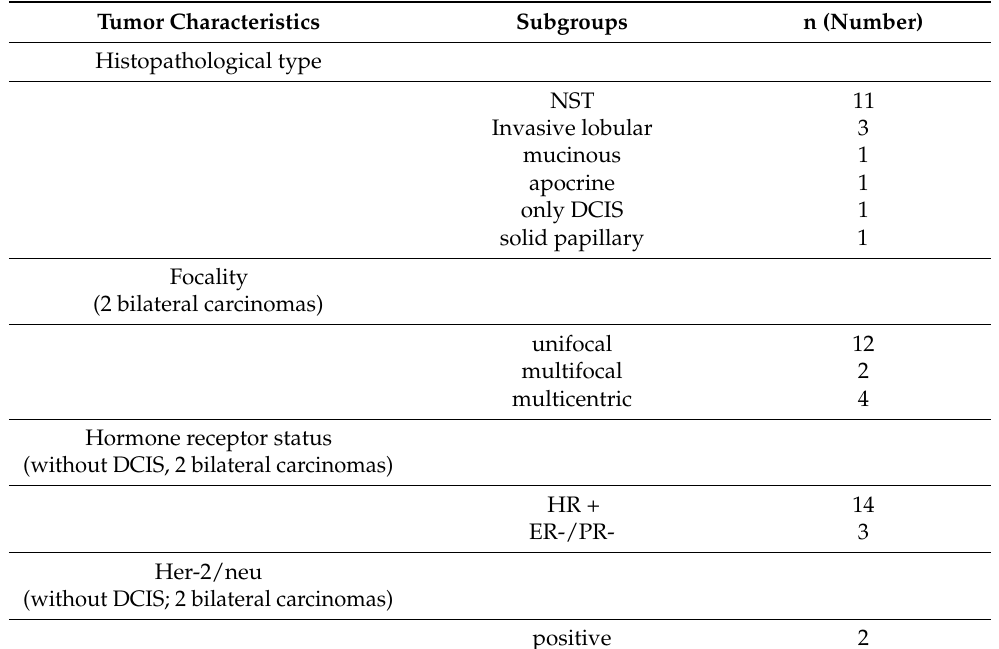
Table 1. Description of tumor characteristics of 16 patients and 18 tumors (2